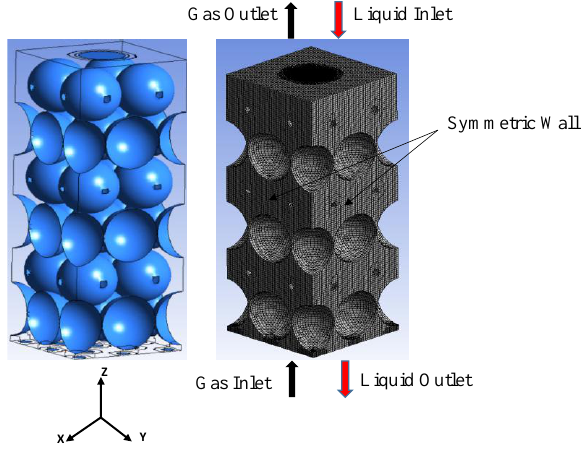
Figure 3. 3D geometry and meshed model.